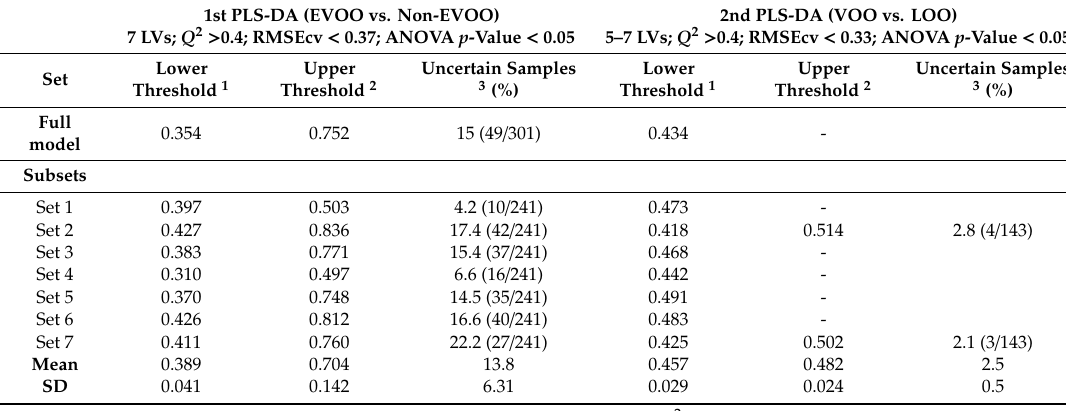
Table 1. Uncertainty ranges obtained from receiver operating characteristics (ROC) curves and uncertain samples for each classification model, obtained during internal validation of seven di ff erent subsets (leave-10%-out cross-validation).